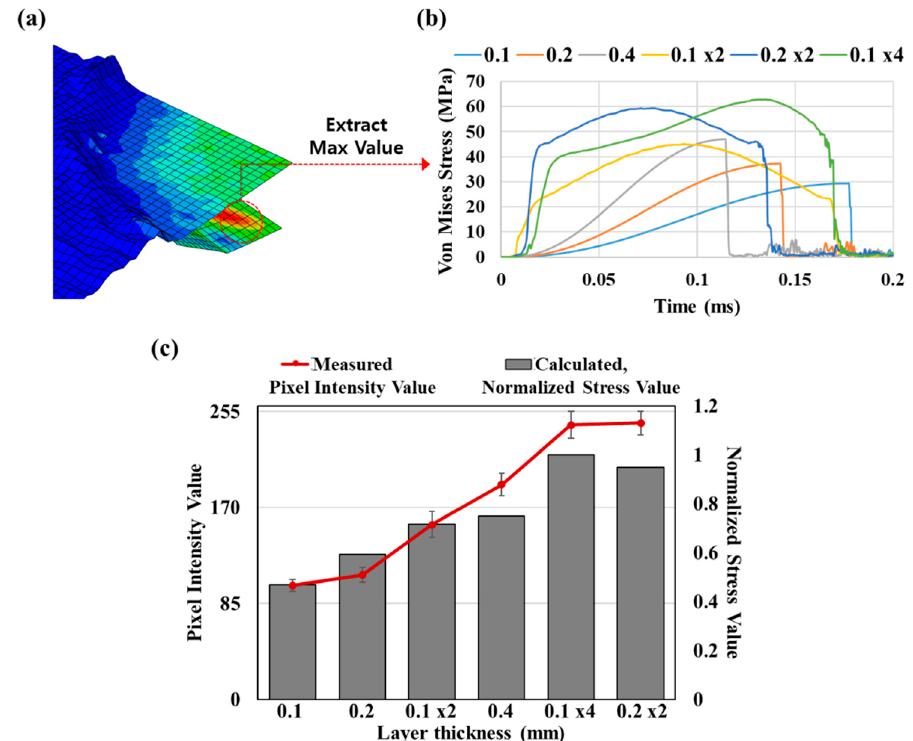
Figure 6. Von Mises stress value of ML/PVDF composites with different thicknesses and layers. ( a ) The von Mises stress contour. For the two-layer composites, the deformation scale factor of 10 was used; ( b ) von Mises stress curve as a function of time. ( c ) Comparison of simulated normalized stress value of ML/PVDF composites and actual PIV after experiments with different thicknesses and layers.